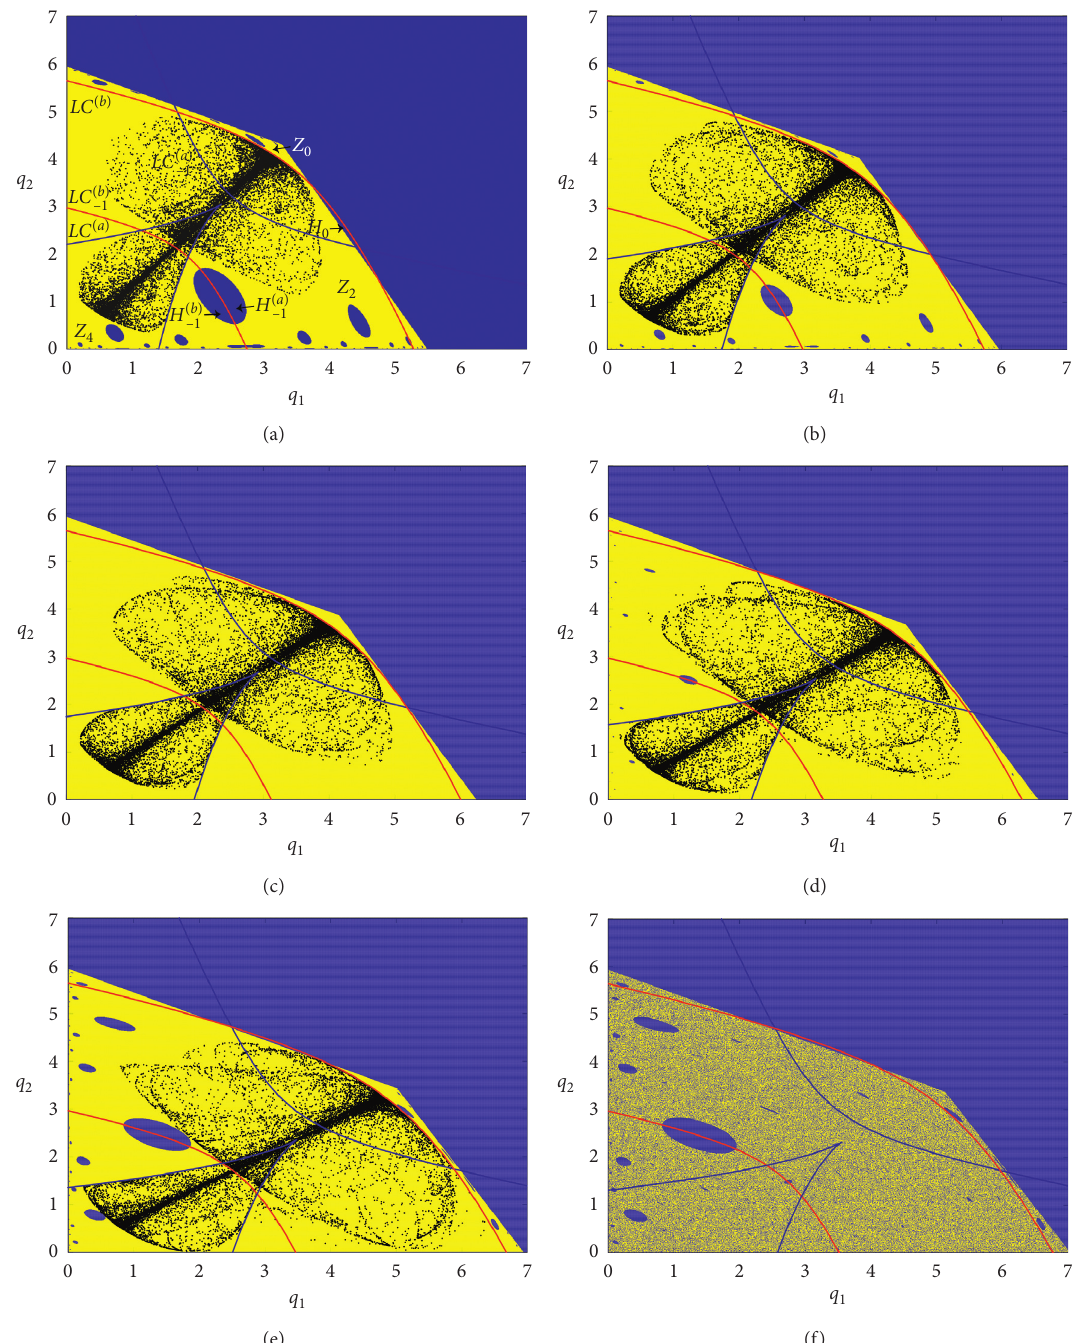
Figure 6: Various basins of attraction under parameters a − c values. (a) α � 0 . 1; (b) α � 0 . 2; (c) α � 0 . 25; (d) α � 0 . 3; (e) α � 0 . 36; (f) α � 0 .